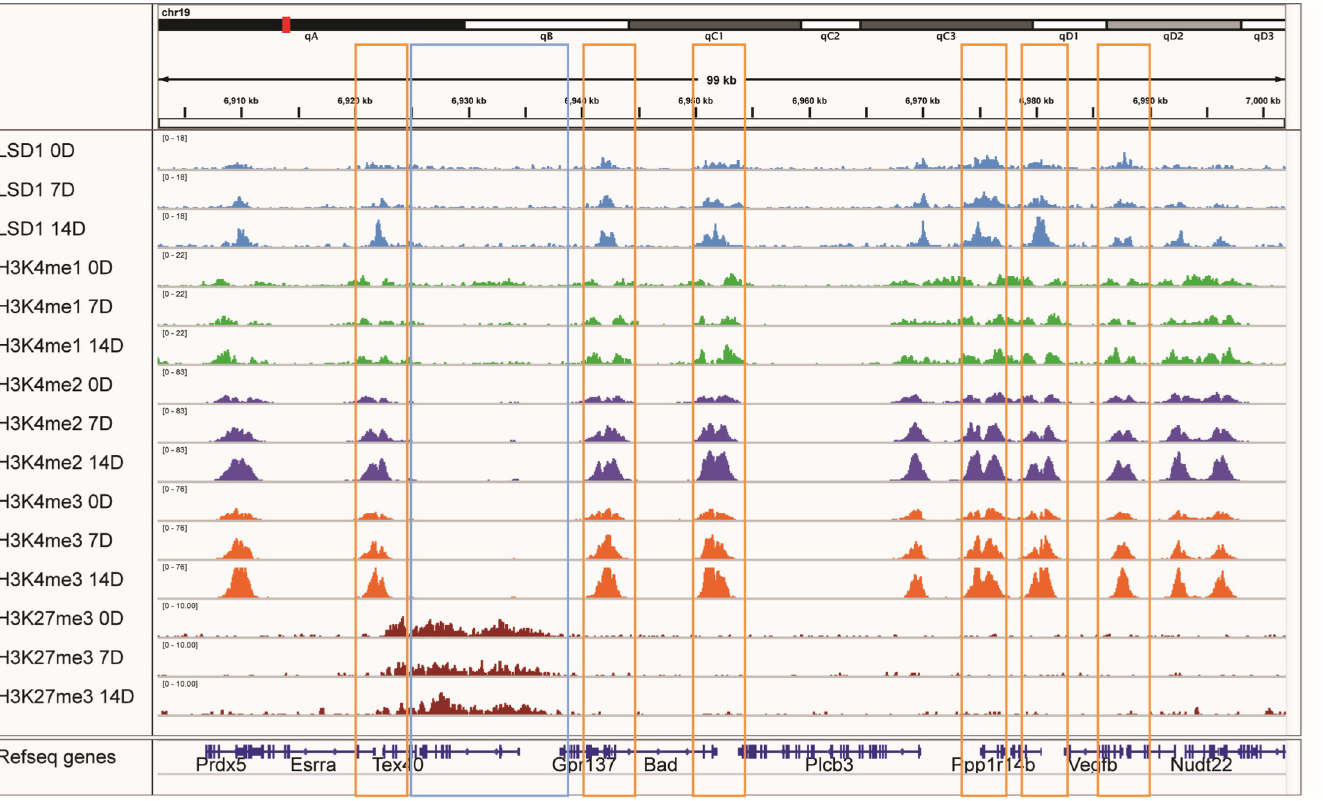
Fig 8. Examples of H3K4 methylation patterns at Lsd1 bound promoters and enhancers visualized by integrative genomic viewer (IGV). View of chromosome 19 with several expressed genes.